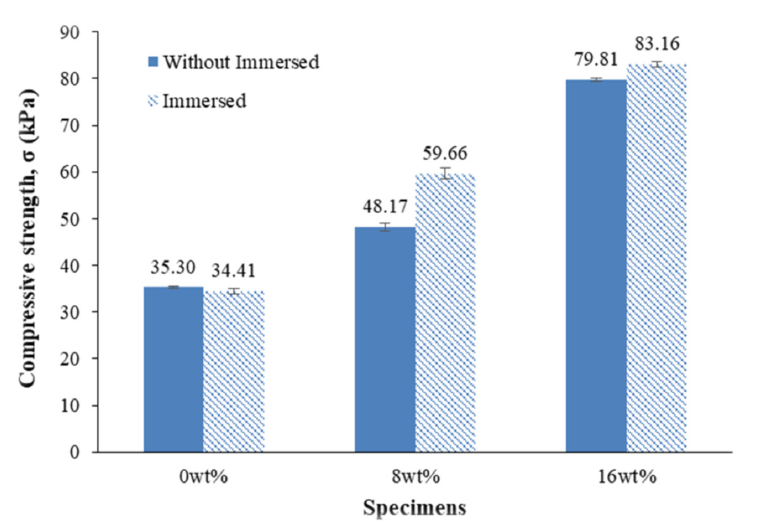
Figure 2. Comparison of the average ultimate compressive strength of bamboo fibre–reinforced sil- icone rubber biocomposites among specimens with and without immersion in seawater. silicone rubber biocomposites among specimens with and without immersion in